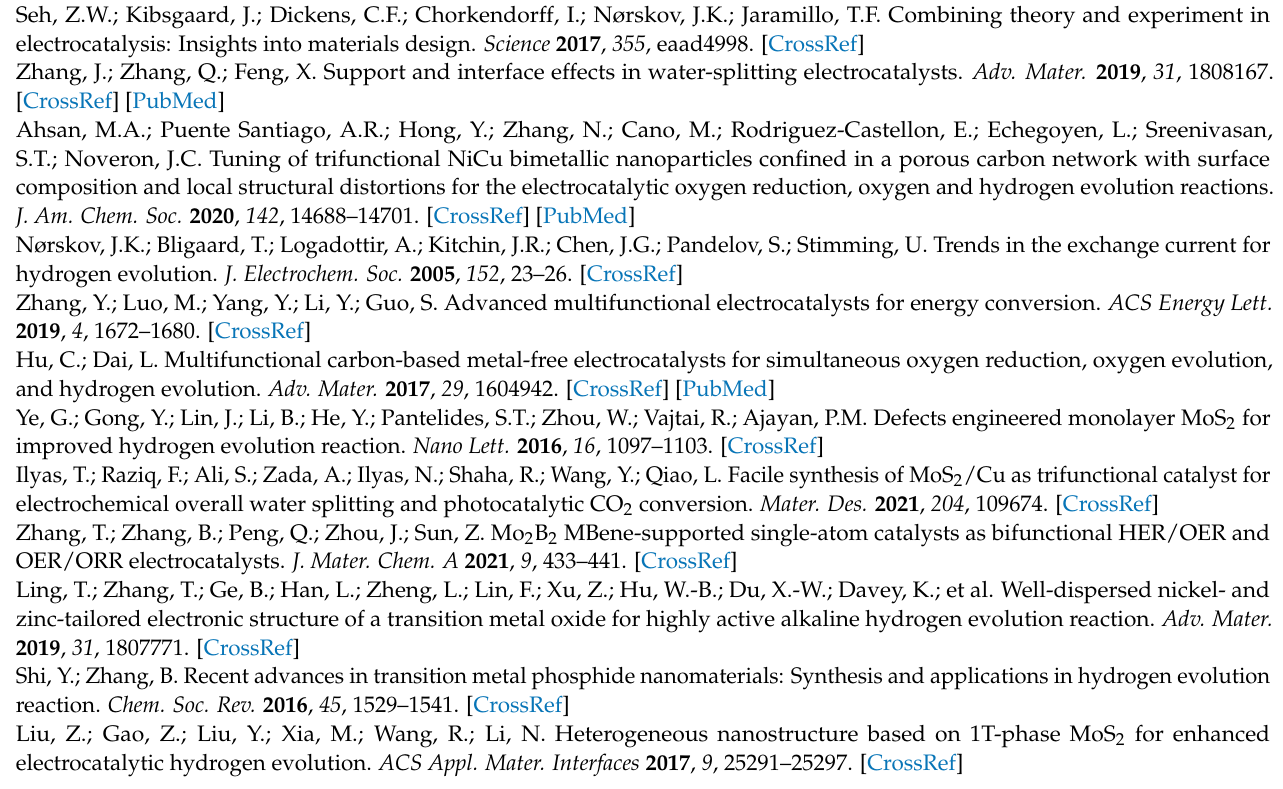
Figure S3: H atom adsorption configuration on PdTi@1T-MoS 2 , Table S1: The elastic constants C 11 , criteria, Table S2: The total energy E tot and free energy ∆ G H* of H* adsorption on TM@1T-MoS 2 ,